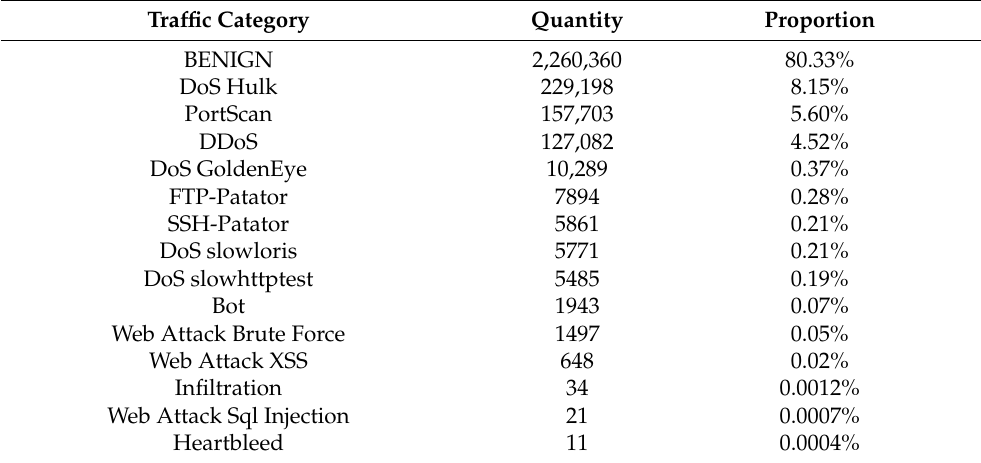
Table 2. The categories and quantities of dataset